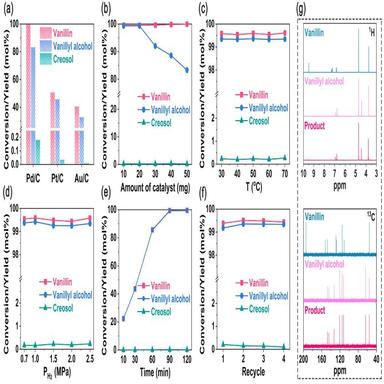
Vanillin hydrogenation reaction (a. Different catalysts; b. Amount of Pd/C; c. Reaction temperature; d. Pressure of H2; e. Reaction time; f. Stability of the Pd/ C.). The 400 MHz 1 H and 13C NMR spectrums of vanillin, vanillyl alcohol, and the hydrogenated product (g).